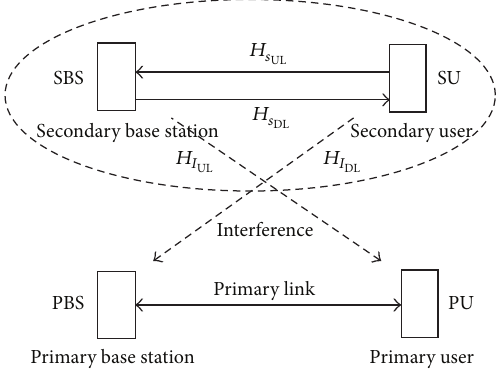
Figure 1: The underlay CR network